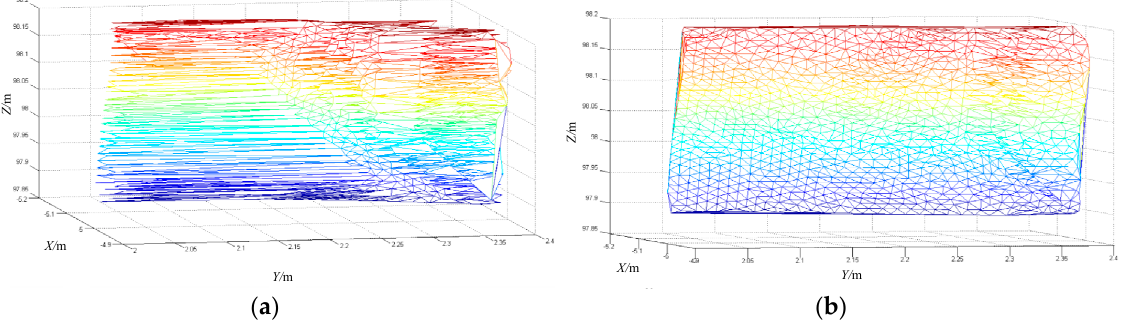
Figure 3. Triangulation results for 3D plane as the projection plane. ( a ) XOZ; ( b ) YOZ. Table 2. Triangular area variance of triangular mesh generated by different projection surfaces.